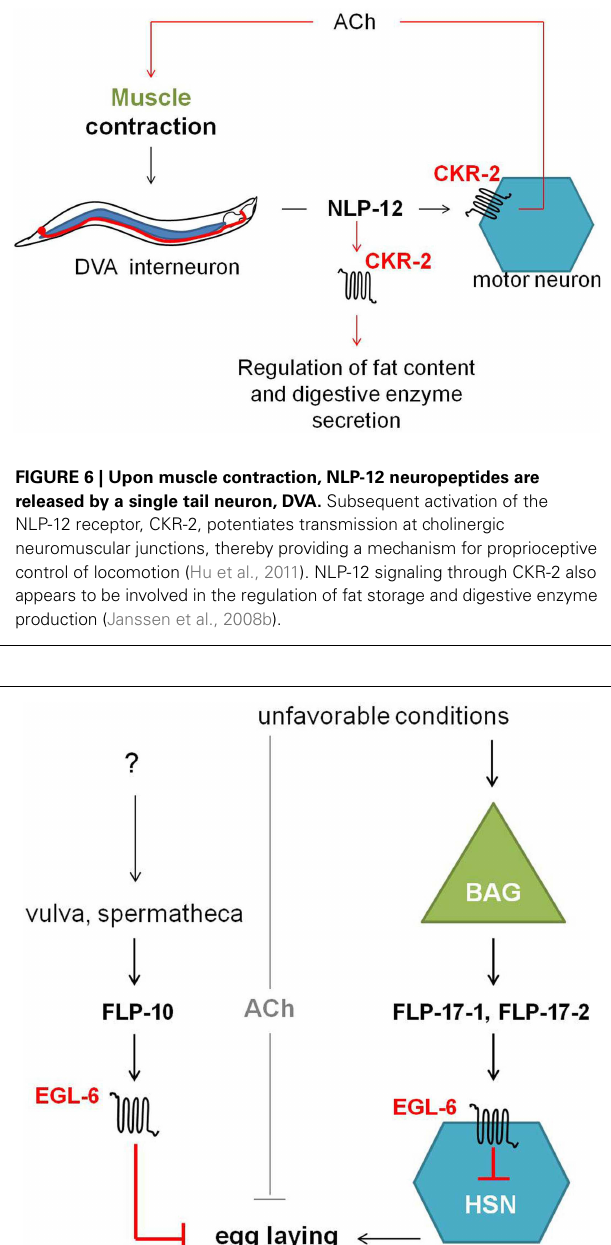
on EGL-6 in HSN motor neurons. The latter neurons are known to stimulate the action of vulval muscles and are involved in egg- laying (Trent et al., 1983; White et al., 1986). The